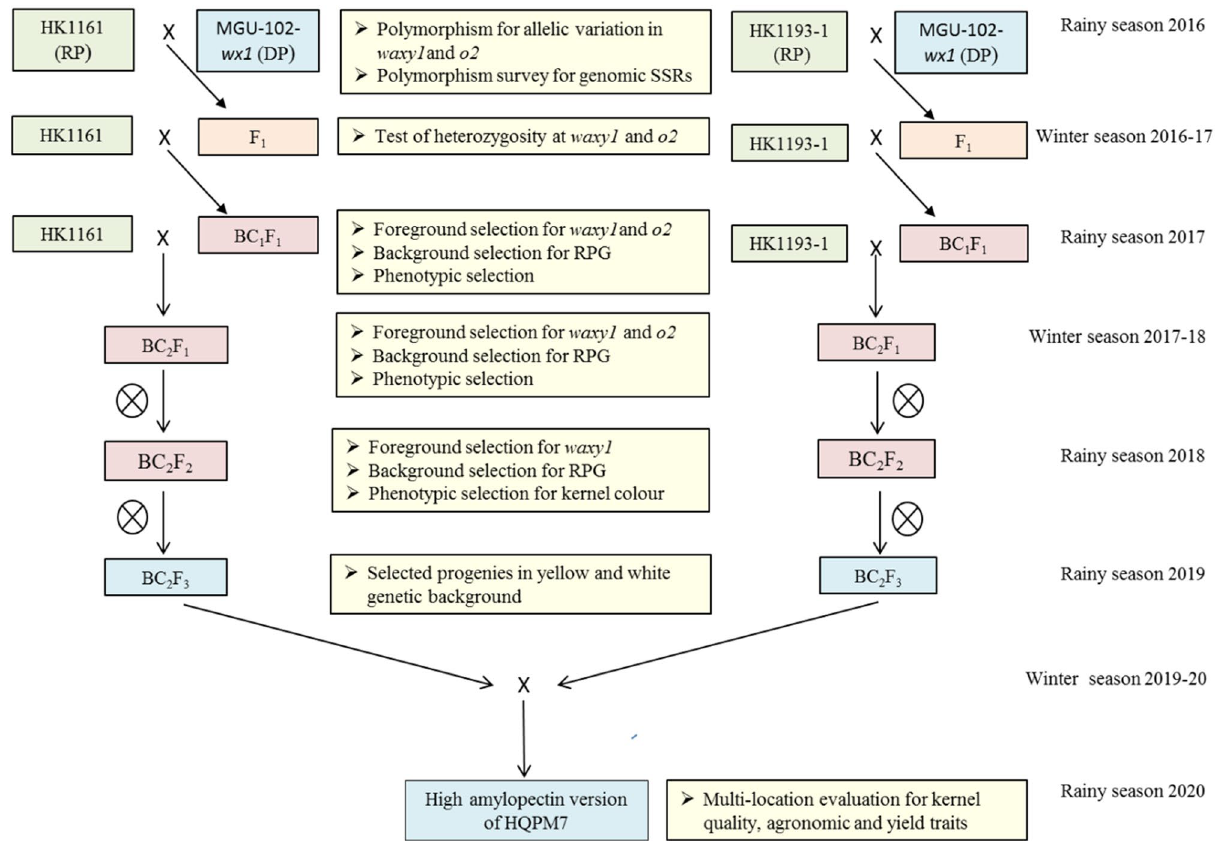
Figure 1. Marker-assisted backcross breeding (MABB) scheme followed for development of amylopectin rich waxy version of HQPM7. RP: recurrent parent: DP: donor